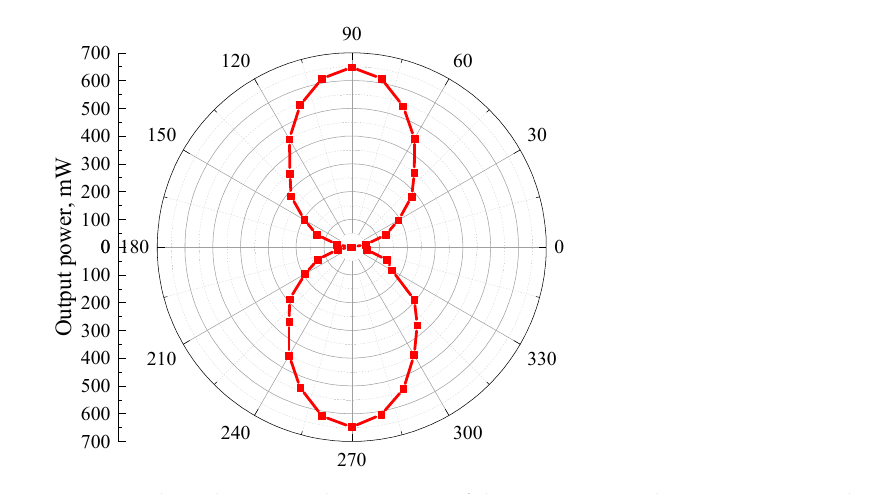
Figure 5. The polarization characteristic of the SLM 1123 nm laser at 7.65 W incident pump power.